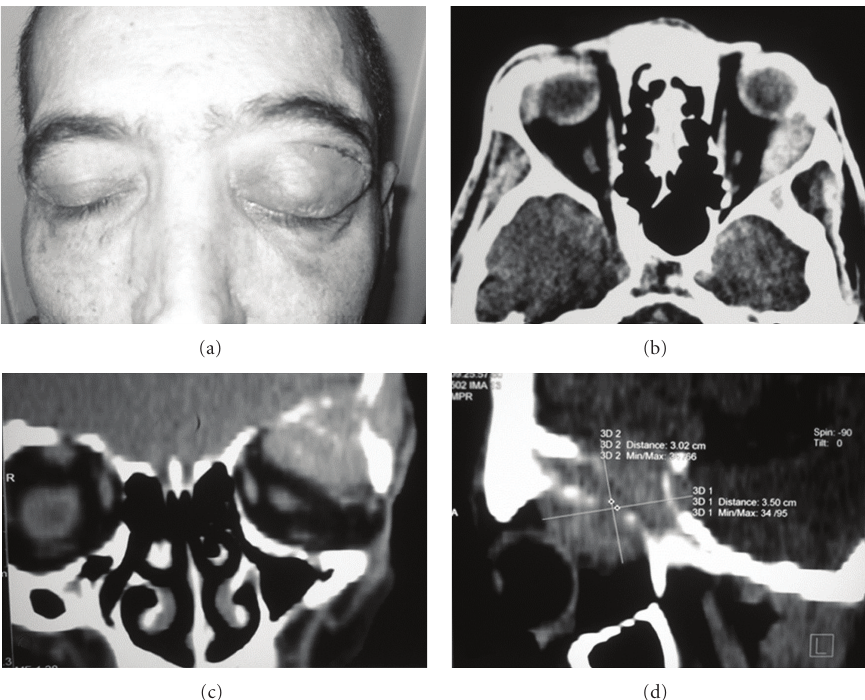
Figure 1: (a) Proptosis of the left eye, (b), (c), and (d) computed tomography (CT) scans of the orbit that showed an extraconal mass involving the superior and lateral wall of the left orbit with destruction of the orbital bone, incorporating the lateral rectus, with calcifications.